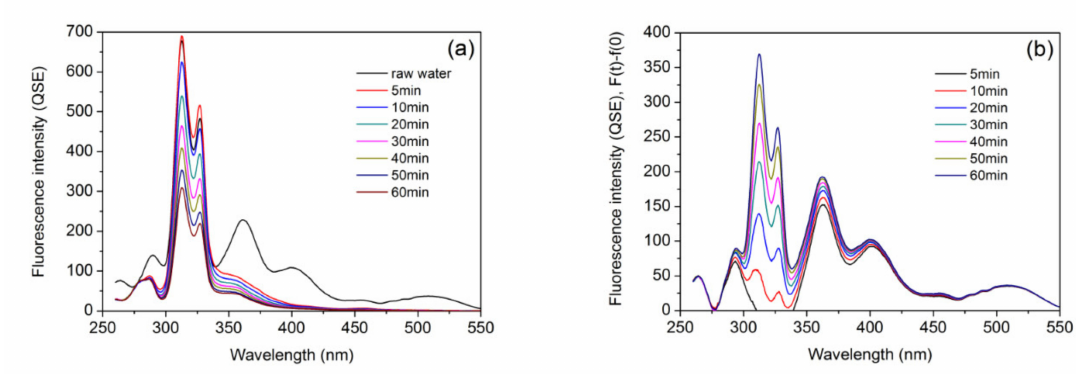
Figure 2. Changes in spectral responses of PTW with di ff erent irradiation times in UV / O 3 system: ( a ) synchronous fluorescence spectroscopy (SFS) ( ∆ λ = 18 nm) and ( b ) absolute fluorescence losses of excitation wavelength